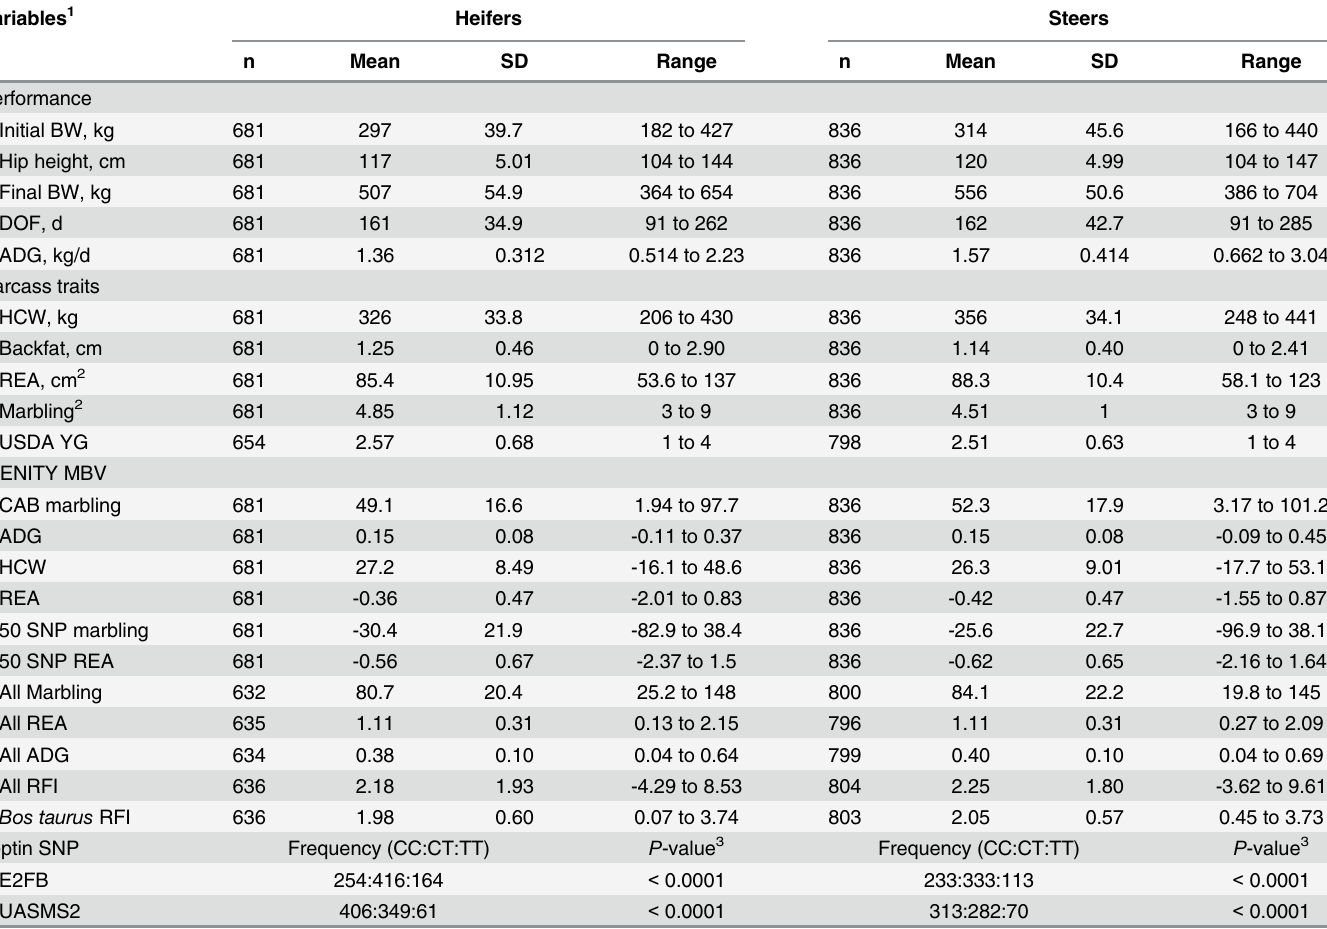
Table 1. Descriptive statistics of the database for heifers and steers (N =